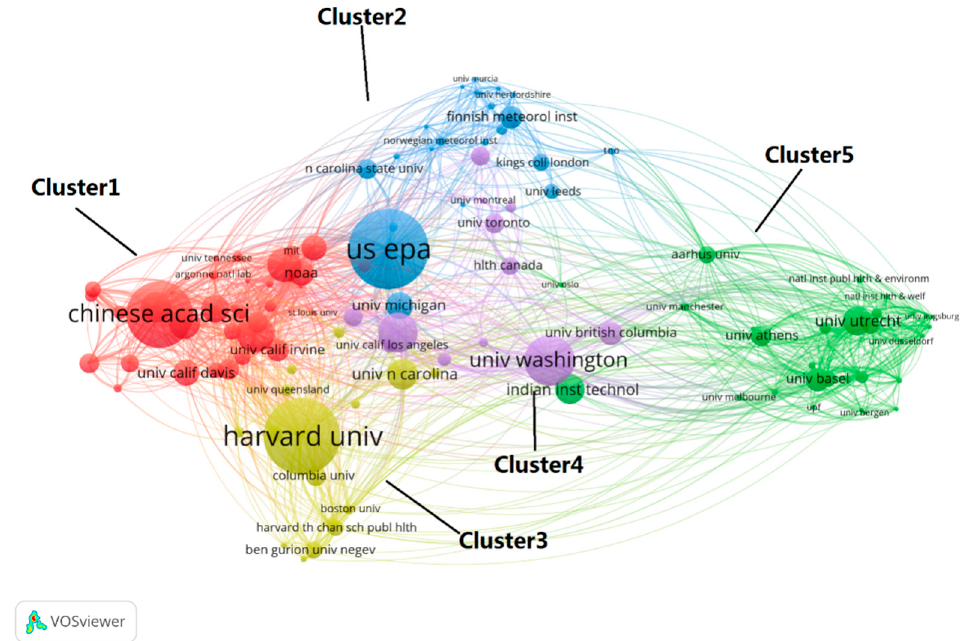
Figure A1. A cooperation map of research institutions producing studies involving air pollutant prediction from 1990 to 2018 (note: the node size in the figure represents the number of documents issued by the institution, and the connection between nodes represents the cooperation between institutions; the more connections, the closer the partnership).